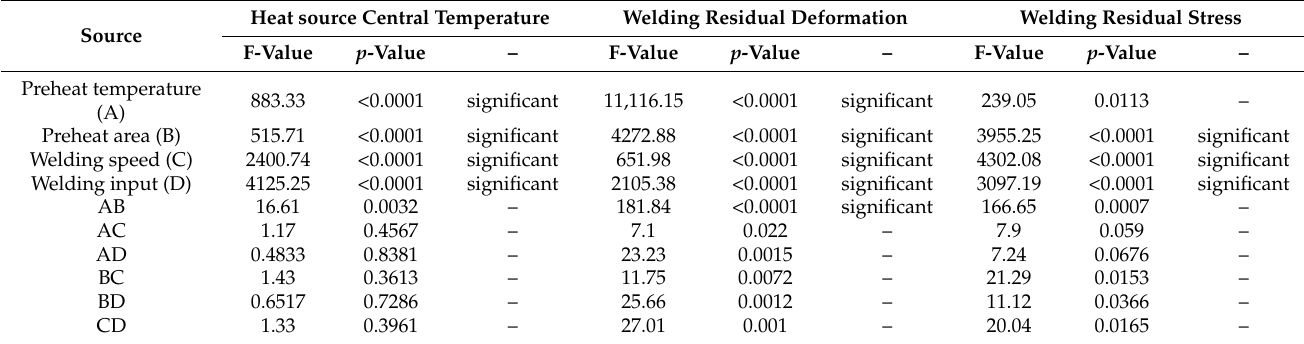
Table 5. The ANOVA for heat source central temperature, welding residual deformation and